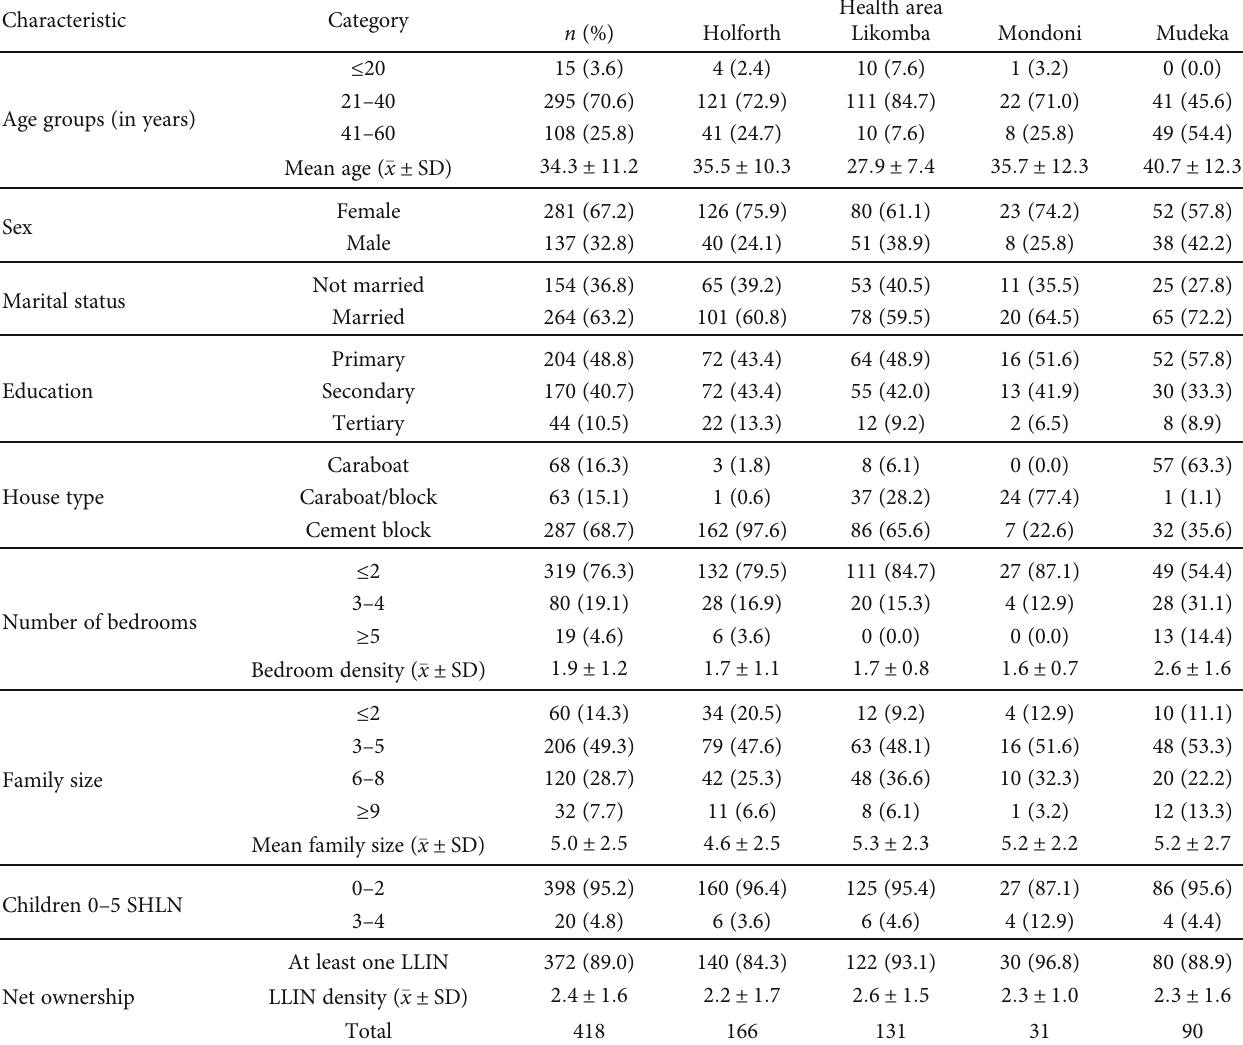
Table 1: Sociodemographic characteristics of the study population.